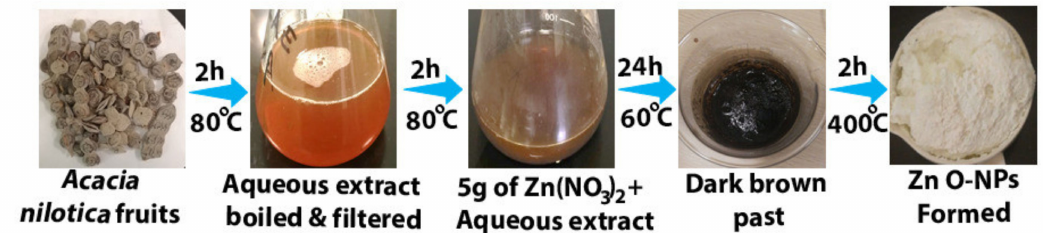
Figure 10. ZnO-NPs synthesized steps by using Acacia nilotica